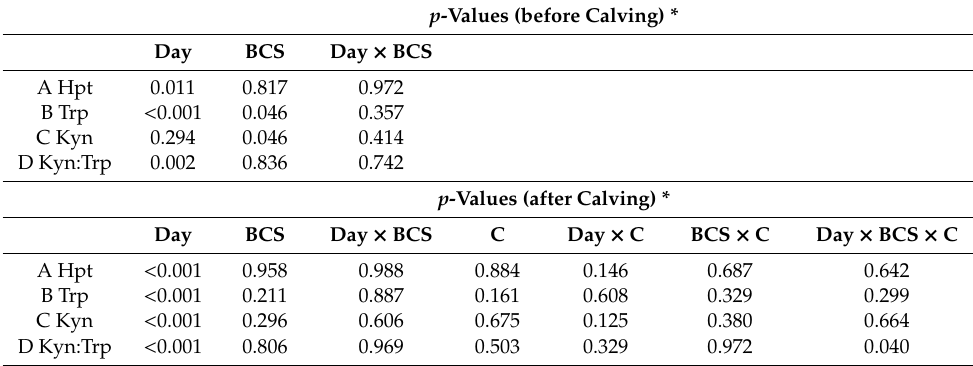
Table 4. Model corresponding to Figure